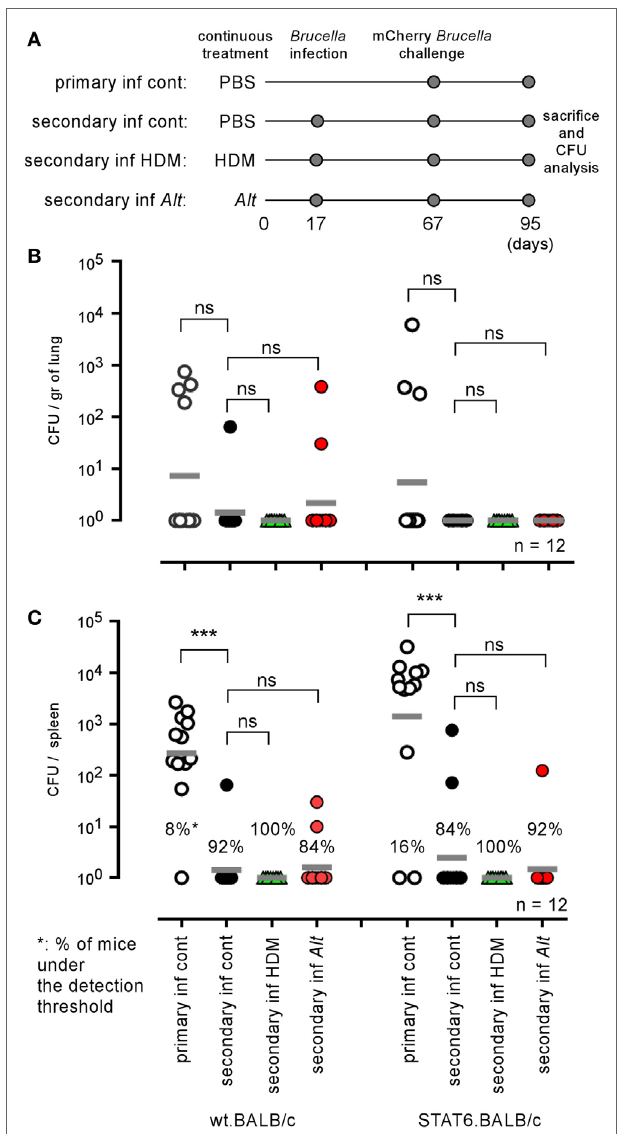
FigUre 10 | Influence of allergic asthma on the development of protective memory against Brucella melitensis . Wild-type and STAT-6 − / − BALB/c mice were sensitized with phosphate-buffered saline (PBS), HDM, or Alt extracts, as described in the Section “Materials and Methods,” throughout the entire experiment. Primary and secondary groups received i.n. administration of PBS or 2 × 10 4 CFU of wild-type B. melitensis at 17 days, respectively. All groups were infected i.n. with 2 × 10 4 CFU of mCherry- B. melitensis at 67 days, were sacrificed at 95 days, and the spleens were harvested and the CFUs were counted. (a) Is a schematic representation of the protocol. (B,c) Represent the number of CFU/gr of lung (B) and spleen (c) . Horizontal gray lines represent the medians. n denotes the number of mice used for each lineage. These results are representative of at least two independent experiments. *** p <